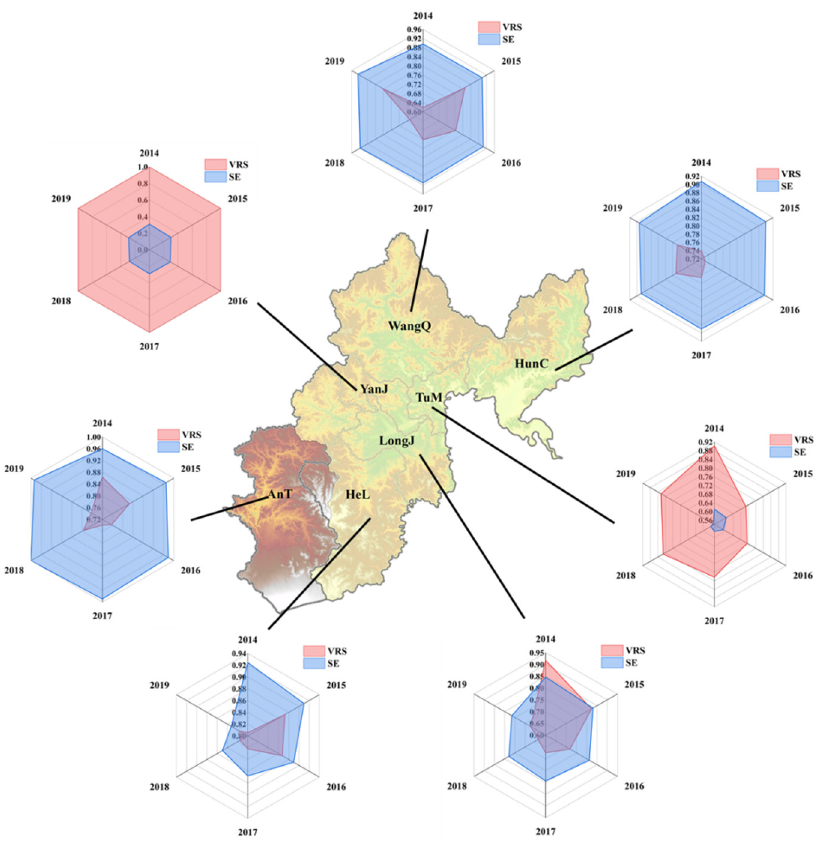
Figure 7. The result of TE and SE for domestic water from 2014 to 2019.